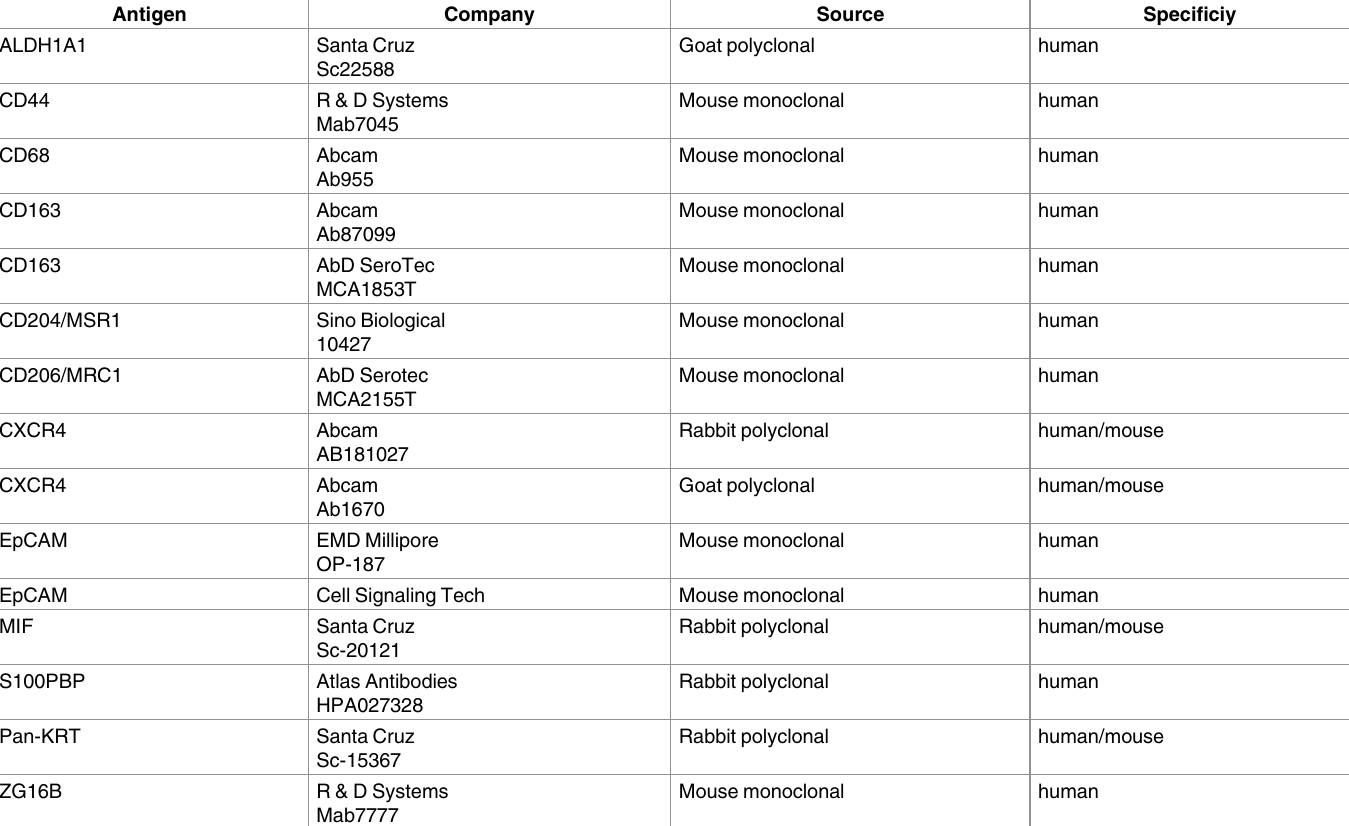
Table 2. Antibodiesused for immunophenotypic